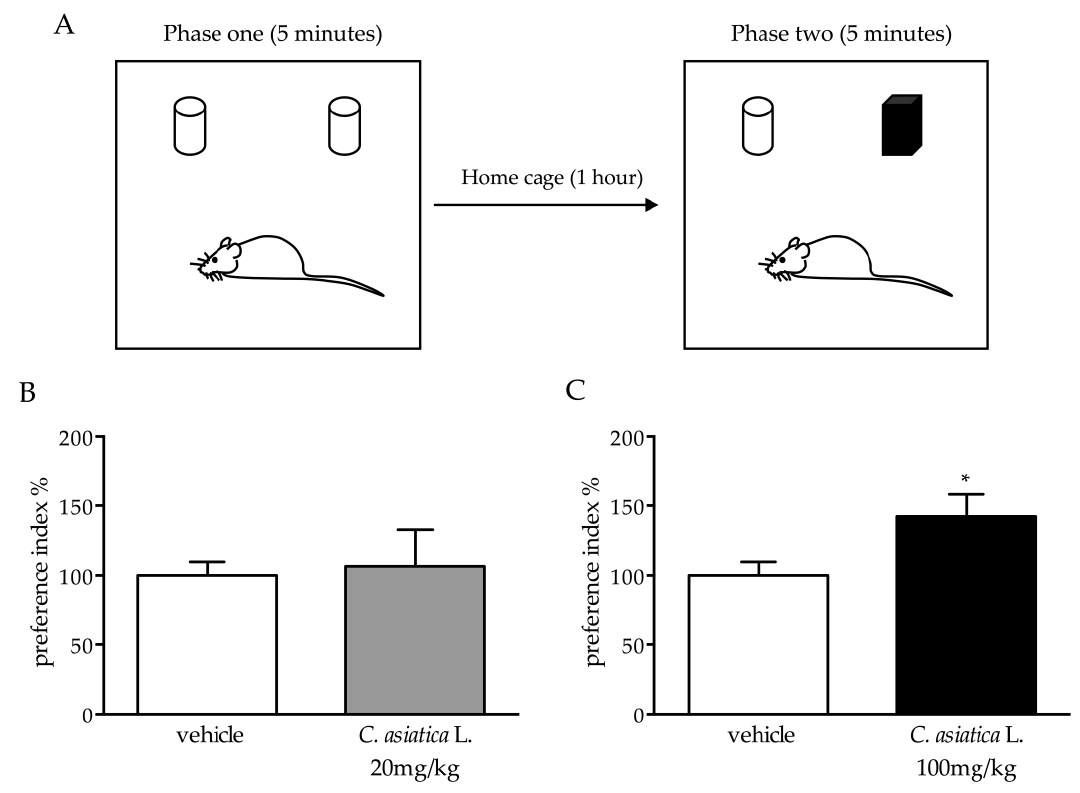
Figure 5. Analysis of cognitive performance of rats that were chronically treated with 20 or 100 mg / kg of C. asiatica L. and exposed to the novel object recognition test. ( A ) schematic representation of the test. ( B , C ) Behavioral results. The data are expressed as a percentage of the vehicle (set at 100%) and are represented as mean SEM of at least five independent determinations. * p < 0.05 vs vehicle (Student’s t test).